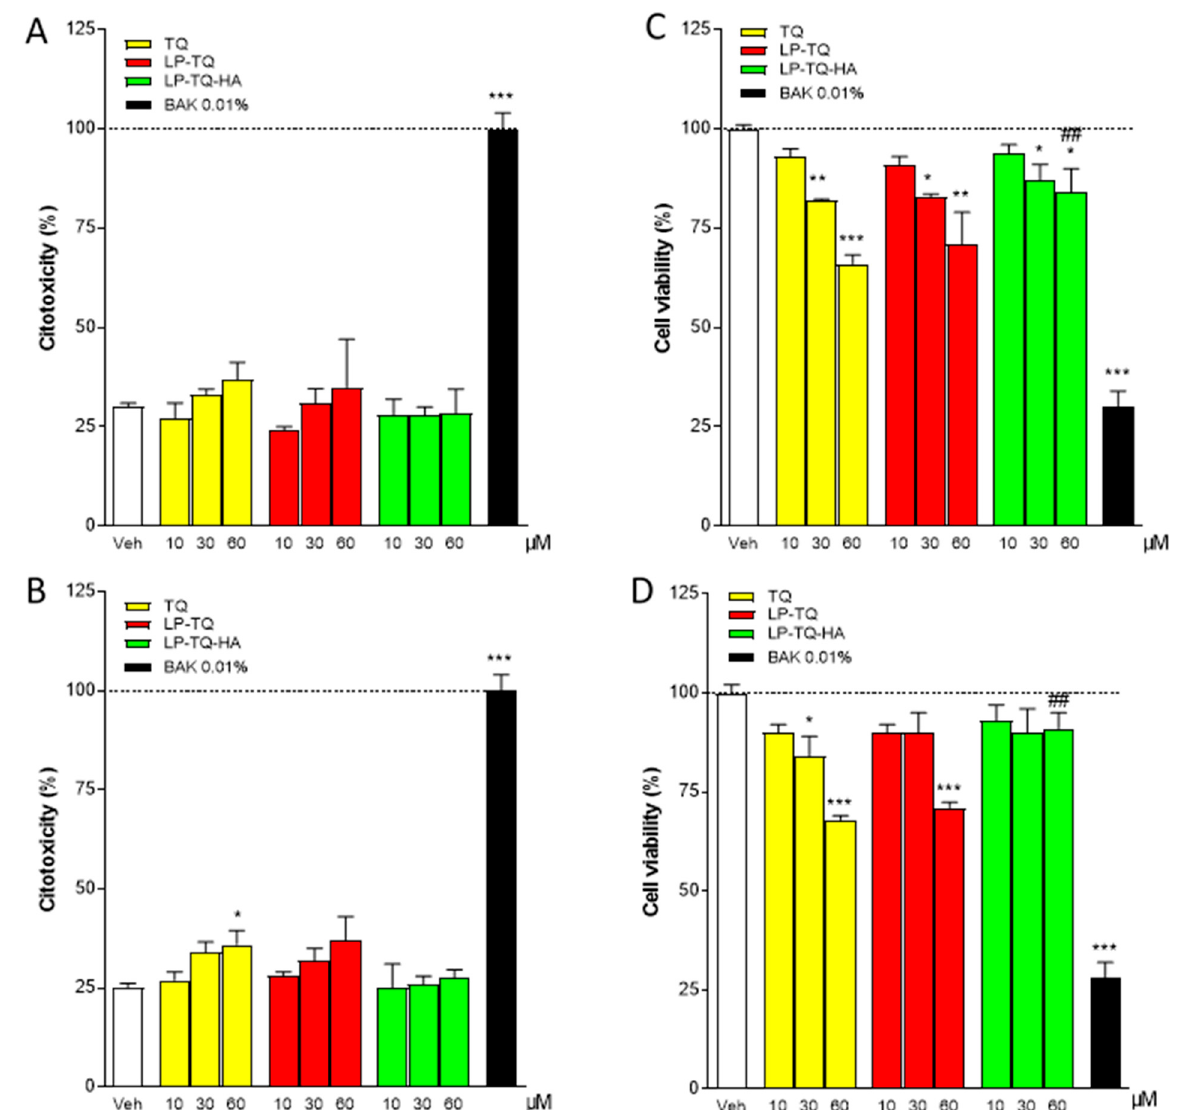
Figure 3. Evaluation of LDH and MTT assay in the human conjunctiva epithelial cells (HConEC) after 15 min ( A , C ) and 1 h ( B , D ) of incubation with TQ, LP-TQ, or LP-TQ-HA components. Data are expressed as percentages of the maximum degree of cell death BAK ( A , B ) and as percentages of the maximum cell viability (Veh) ( C , D ); they represent the mean ± standard error of the mean of at least 3 experiments performed in triplicate. * p < 0.05; ** p < 0.01, and *** p < 0.001 vs. Veh; ## p < 0.01 vs. 60 µ M TQ free.